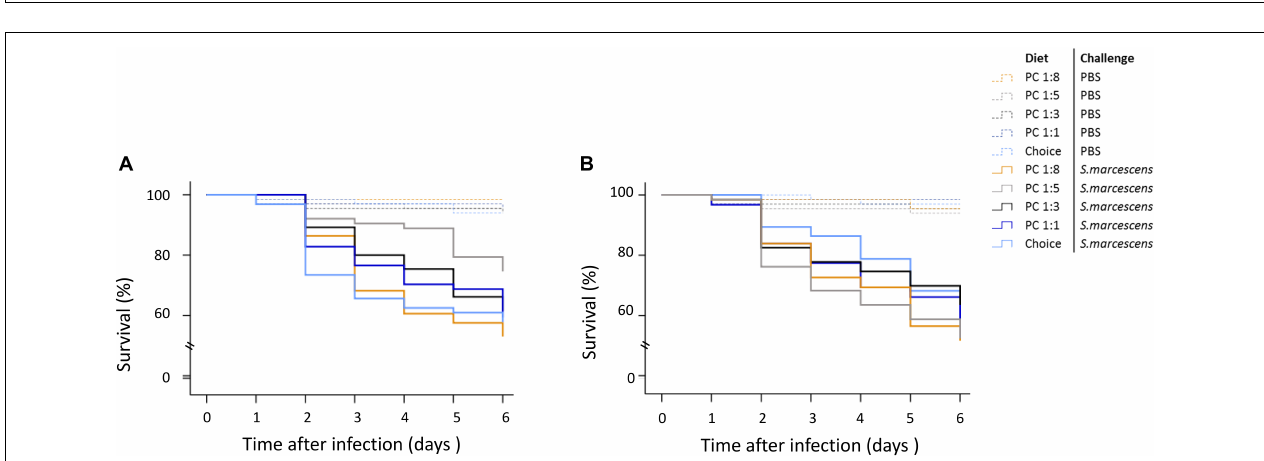
FIGURE 2 | Effect of maternal diet on hatching percentage. Mothers were fed five diets varying in the protein-to-carbohydrate ratio (PC ratio) and egg hatching rate was measured. Bars indicate the percentage of egg hatching. Letters above bars indicate significant difference of egg hatching percentage between diet treatments. Significance was accessed by Student-Newman-Keuls (SNK) test and was considered at P < 0.05.